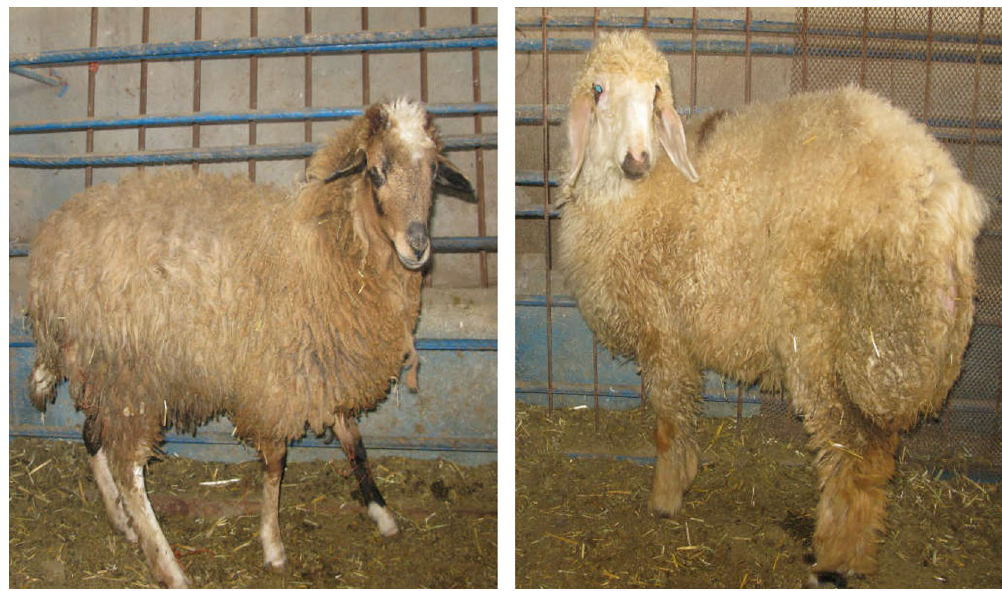
Figure 1. Examples of Zel (thin-tailed breed, left) and Lori-Bakhtiari (fat-tailed breed,